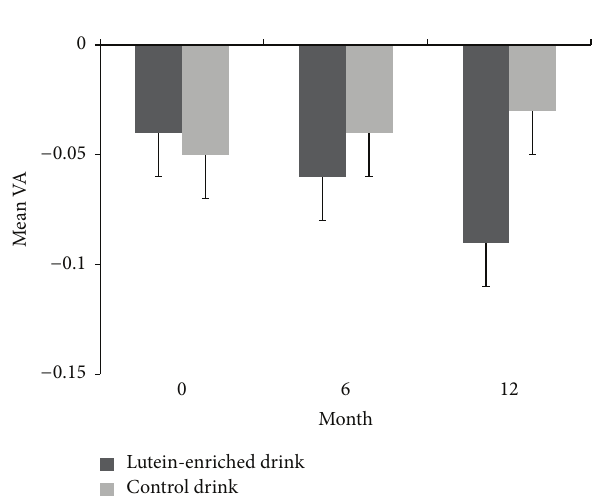
Figure 2: Mean ( ± SE) visual acuity (LogMAR) in time for the lutein group (dark grey) and the placebo group (light grey). Change in lutein group was significantly different from change in control group ( 𝑃 < 0.01